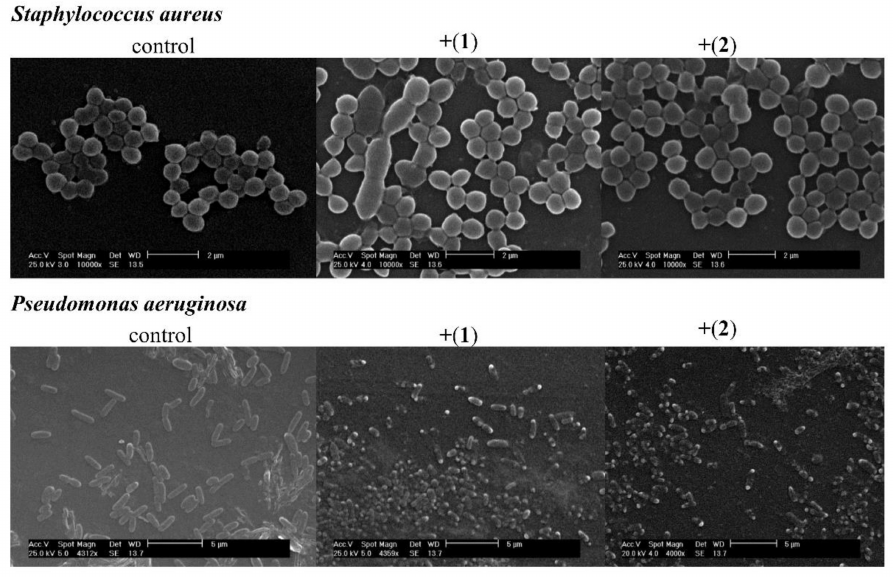
Figure 4. Changes in the cell morphology of Staphylococcus aureus and Pseudomonas aeruginosa cells treated with [CoCl2(dap)2]Cl- ( 1 ) and [CoCl2(en)2]Cl- ( 2 ). Scanning electron microscopy images of S. aureus ATCC 6538 (magnifi- cation 10000x) and Pseudomonas aeruginosa ATCC 9027 (magnification 4000 × ) in the absence (control) and presence of compound ( 1 ) (+( 1 )) and compound ( 2 ) (+( 2